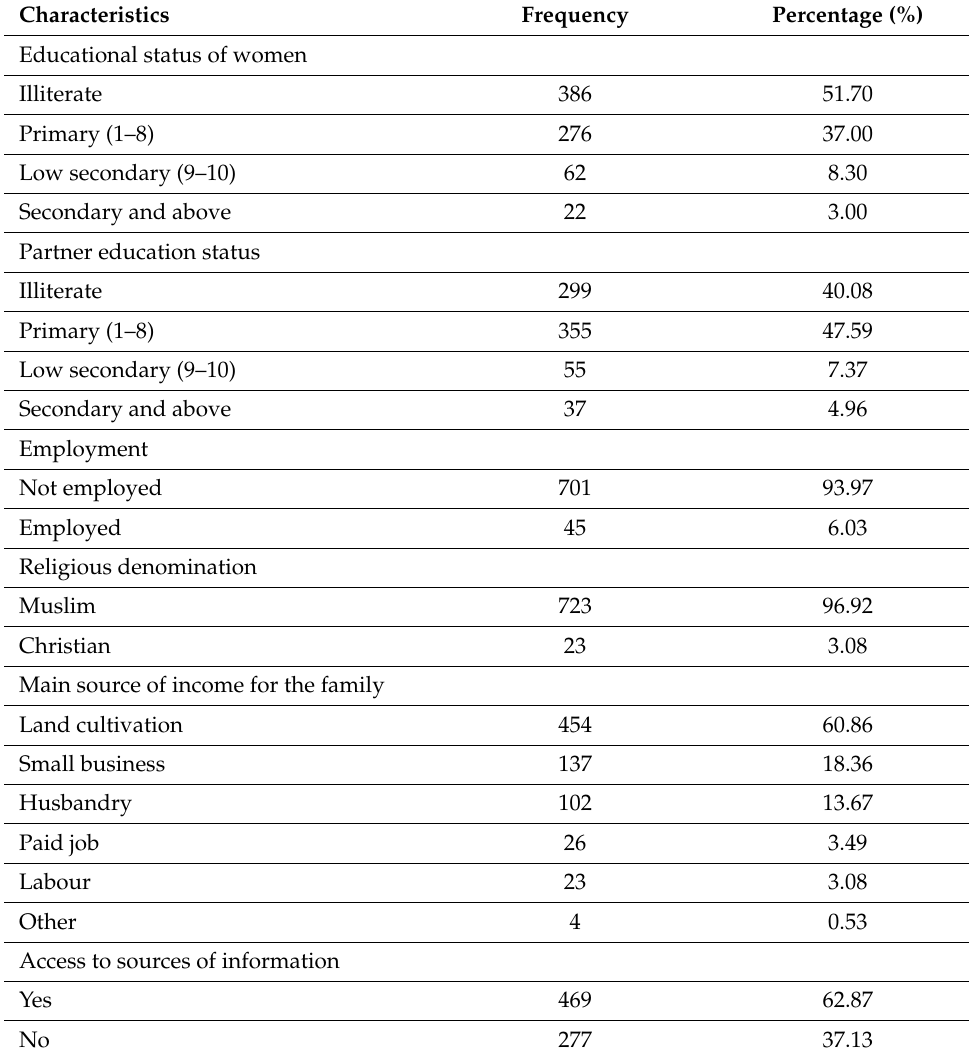
Table 1. Sociodemographic features of the respondents and their partners, Western Ethiopia,